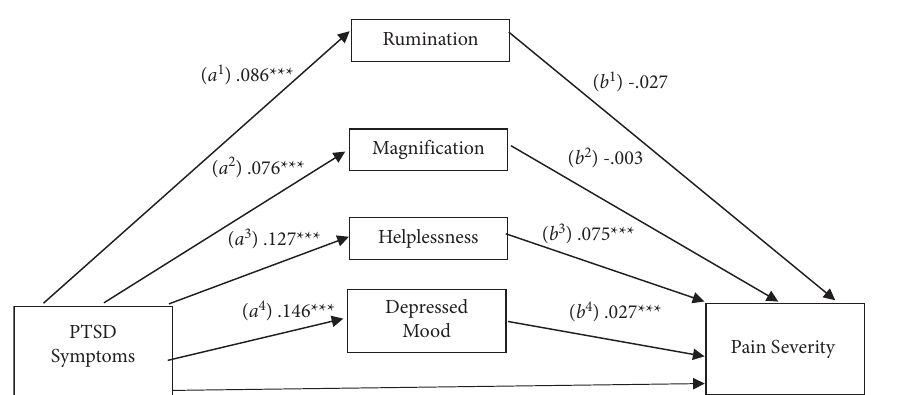
Figure 1: Mediation of the relationship between PTSD symptomatology and pain severity by pain catastrophizing subscales and depressed